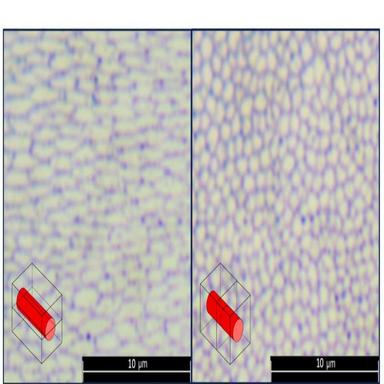
A) columnar and B) dendritic structures inside maraging steel grains observed by an optical microscope.